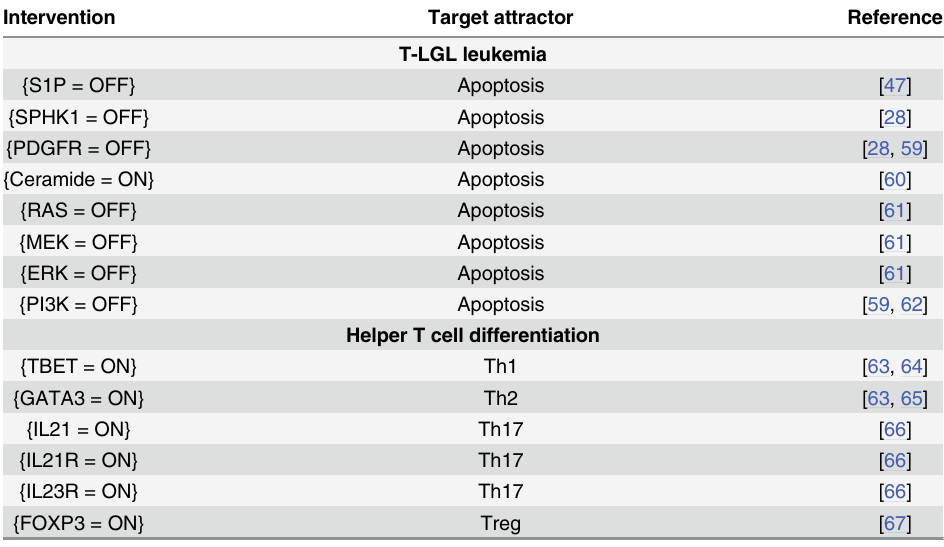
Table 3. Experimental support for successful control targets in Tables 1 and 2.